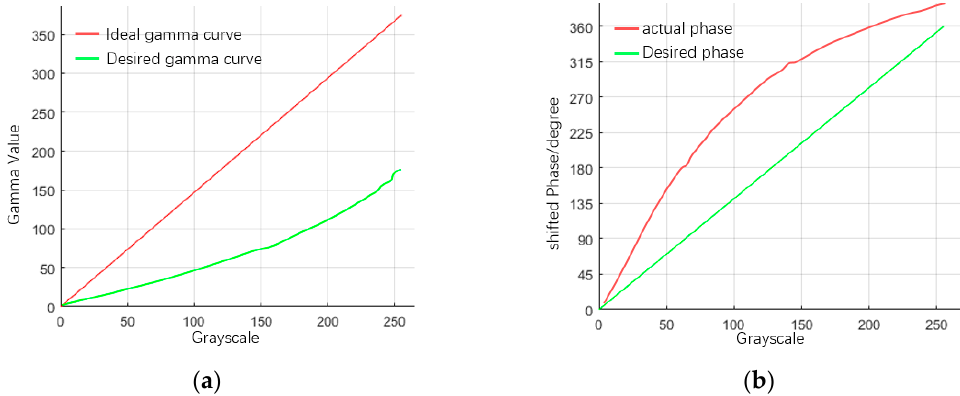
Figure 2. ( a ) The pre-set ideal gamma curve (red) and the desired gamma curve (green) for linear phase modulation. ( b ) The shifted phase modulated by SLM without calibration (red) and the desired linear shifted phase (green) [21] .